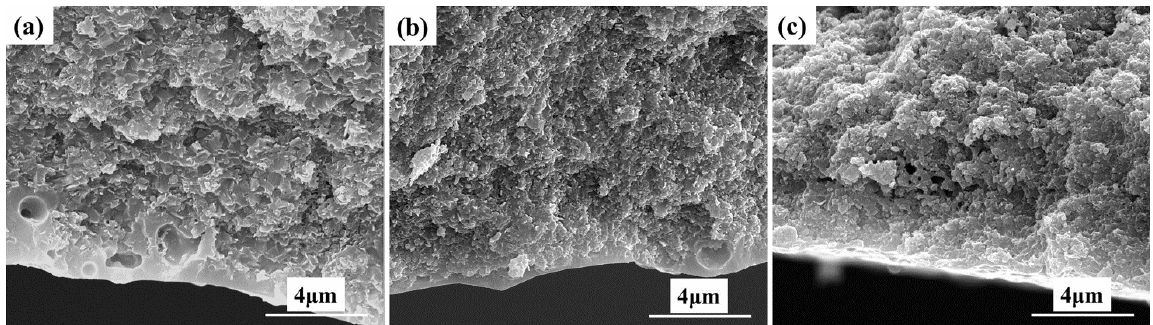
Fig. 7 Fracture surfaces of Si 2 BC 3 N ceramics after the 1st thermal shock: (a) T0, (b) T1, and (c) T3.